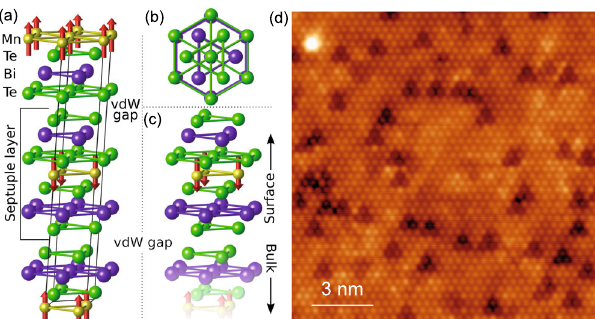
Fig. 1 MnBi 2 Te 4 bulk and surface structure. a Side view of the bulk crystal structure of MnBi 2 Te 4 with red arrows showing the interlayer AFM order. The crystal cleavage in this block-layered compound takes place at the van der Waals gap, thus exposing a Te layer of an SL at the surface. b Top and c side views of the surface crystal structure. d Atomically-resolved STM image of the surface of the cleaved sample (1 V and 0.3 nA) showing dark triangular depressions and a bright circular